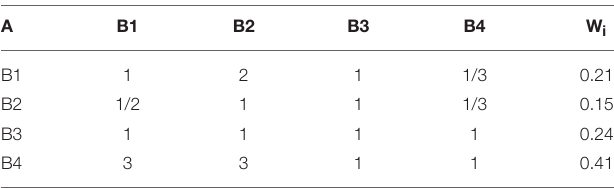
TABLE 5 | Determination of evaluation index weight of Chaishitan water conservancy